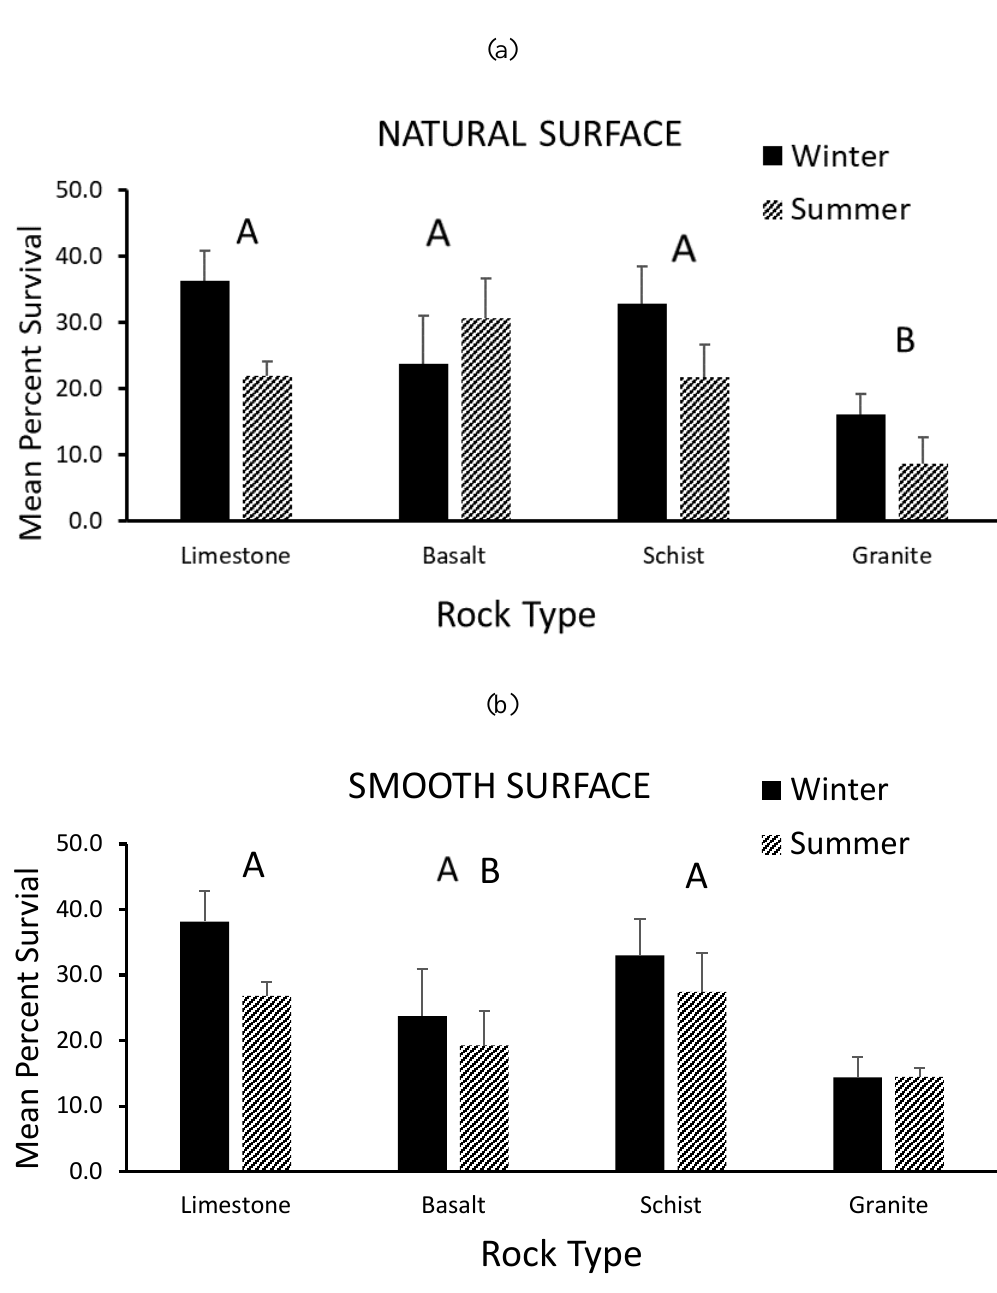
Figure 2. Mean percent survival (+1SE, N = 5) of Fucus spiralis zygotes after one-wave treatment in experiments with natural ( a ) and smooth ( b ) rock surfaces. Percentages are based on mean densities of no-wave treatment for each rock type. Arcsine-transformed proportions were compared between seasons and among rock types for each experiment using a two-way ANOVA. The season x rock type interaction was not significant in either ANOVA ( p > 0.05). Means (by rock type) with a common letter over the bar are not significantly different from each other (Tukey’s HSD post hoc test, p <